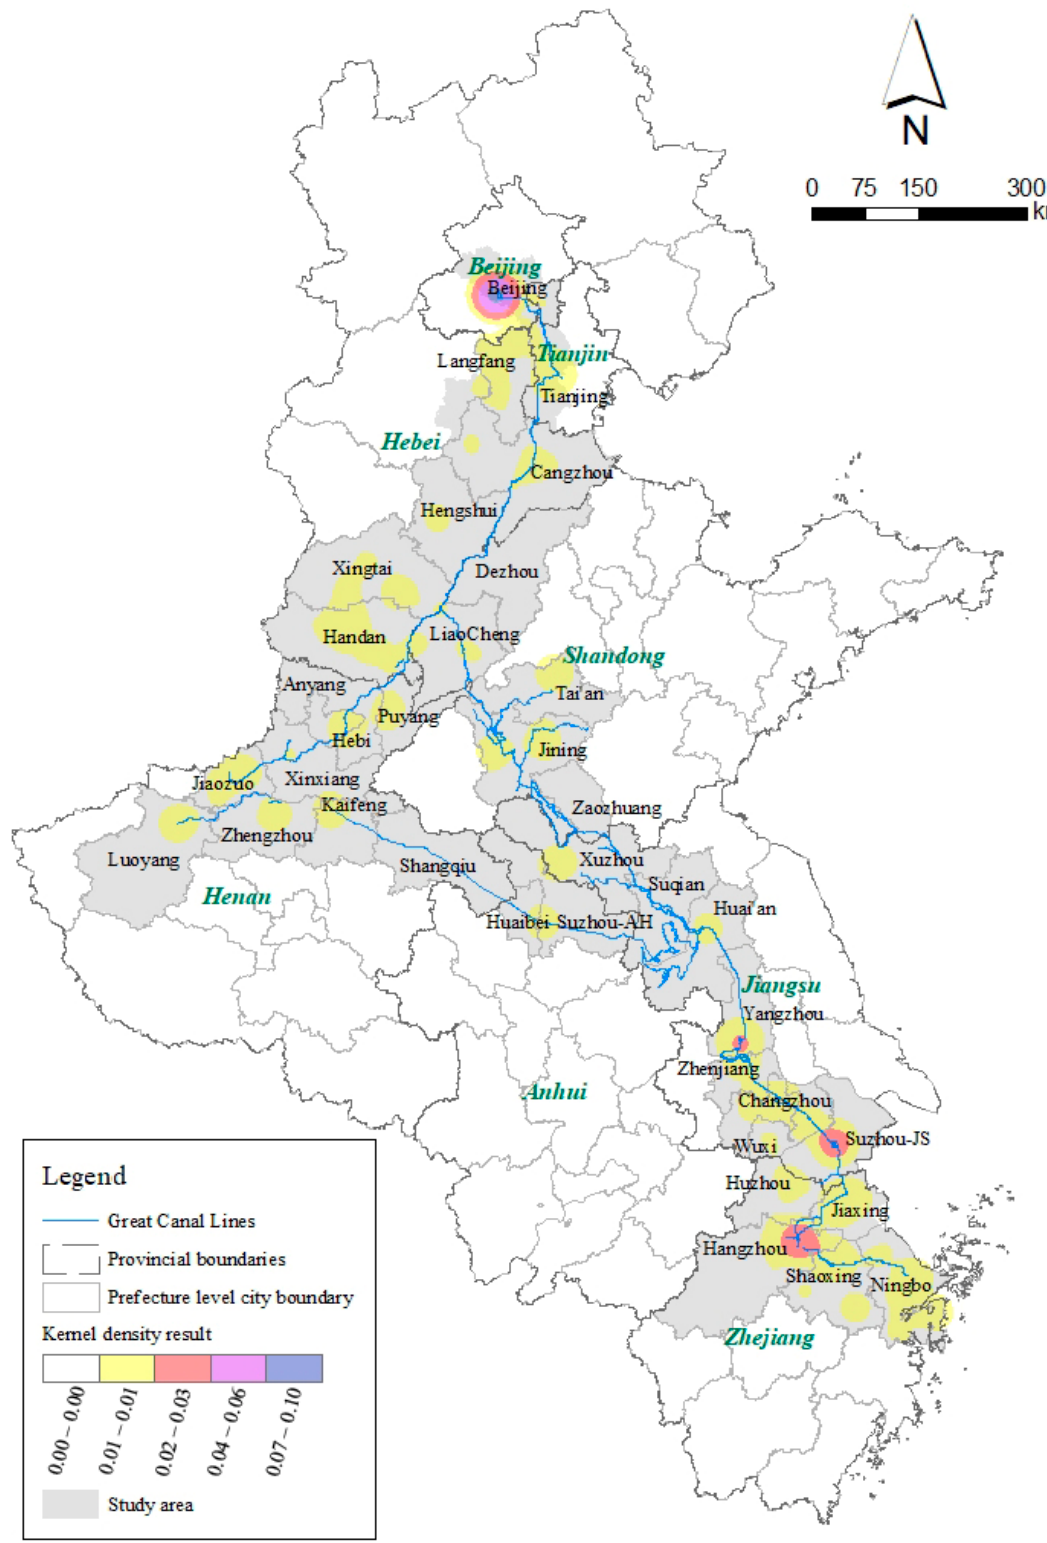
Figure 5. Kernel density of all intangible cultural heritage (ICH) resources.